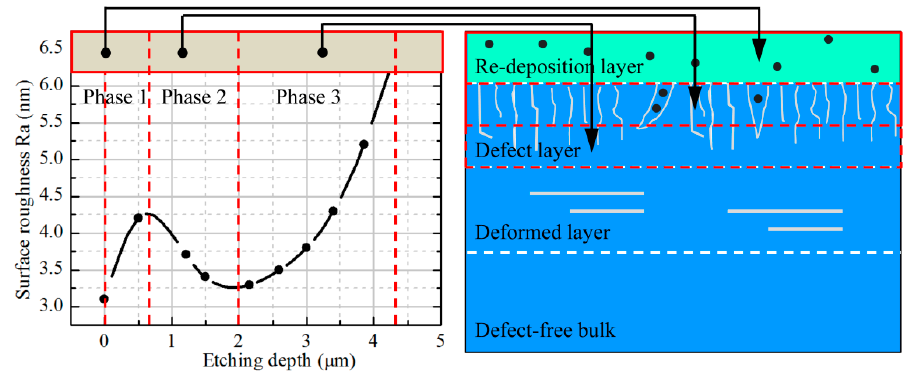
Figure 11. The evolution of surface roughness of etched fused silica optics as the acid etching proceeds and its corresponding etching